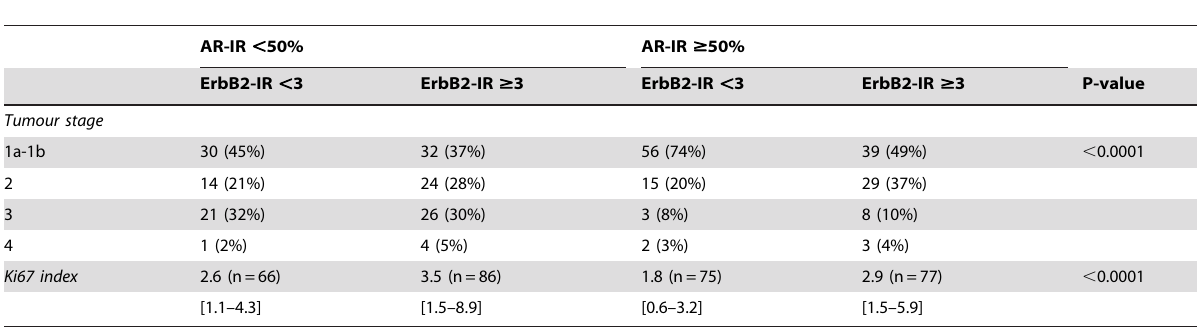
Table 2. Tumour stages for patients with different tumour epithelial ERBb2-AR and AR-IR